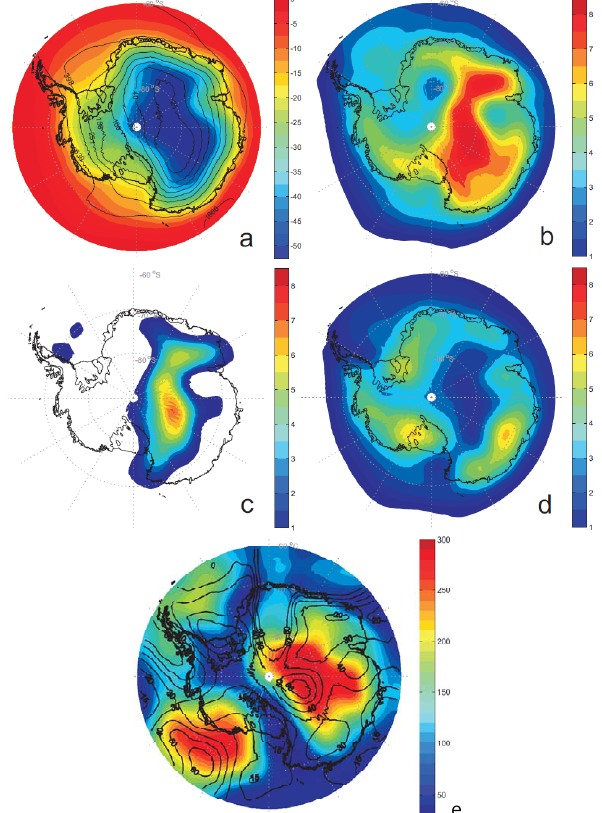
Figure 3. Panel a shows the mean annual 2 m air temperature (shaded) and precipitation (contours show kg/m²/yr equal to mm/yr water equivalent) on a logarithmic interval scale) from 22 years (1980 ‐ 2002) of ECMWF ERA40 data. Panels b ‐ d show the biasing anomaly, ie. the difference between temperature weighted by precipitation and mean annual temperature. Panel b is total biasing (covariance of all frequency temperature and precipitation), contoured at 0.5K intervals; panel c is the seasonal (60 ‐ 375 day biasing signal); and panel d is synoptic (<60 days biasing signal). All data are presented using a 400 km averaging radius (see (Sime et al., 2008)). Figure 3e . The regional coherency of ERA40 inter ‐ annual temperature and precipitation weighted temperature changes. The colour scale displays the number of locations with correlated time ‐ series (R>0.75, 22 years) of temperature (shaded) and precipitation ‐ weighted temperature (contoured) for each grid point.